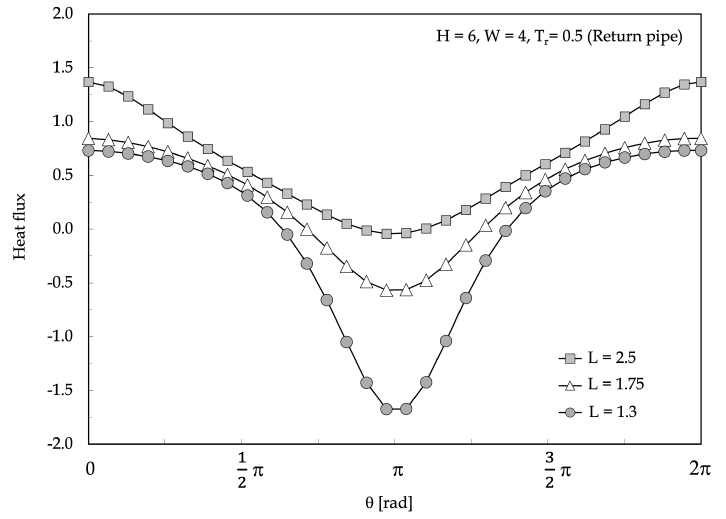
Figure 6. Distributions of the dimensionless local heat loss from the return pipe q r versus angular coordinate θ using L as a